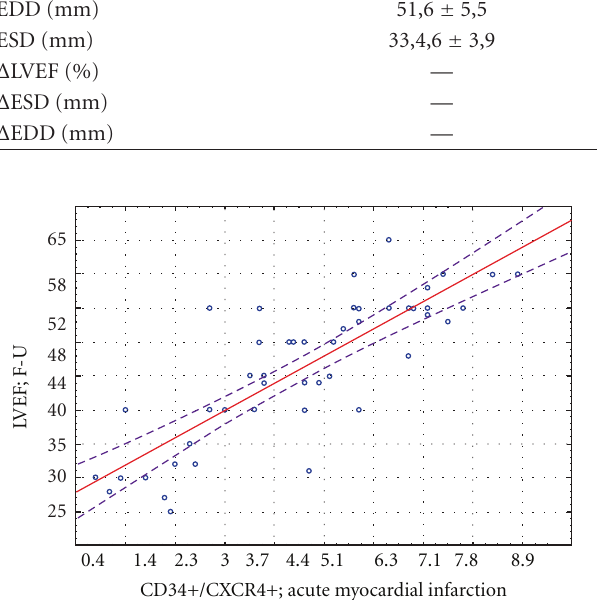
Figure 7: Correlation between peripheral blood CD34+/CXCR4+ progenitor cells number and the absolute LVEF change 12 months post MI.